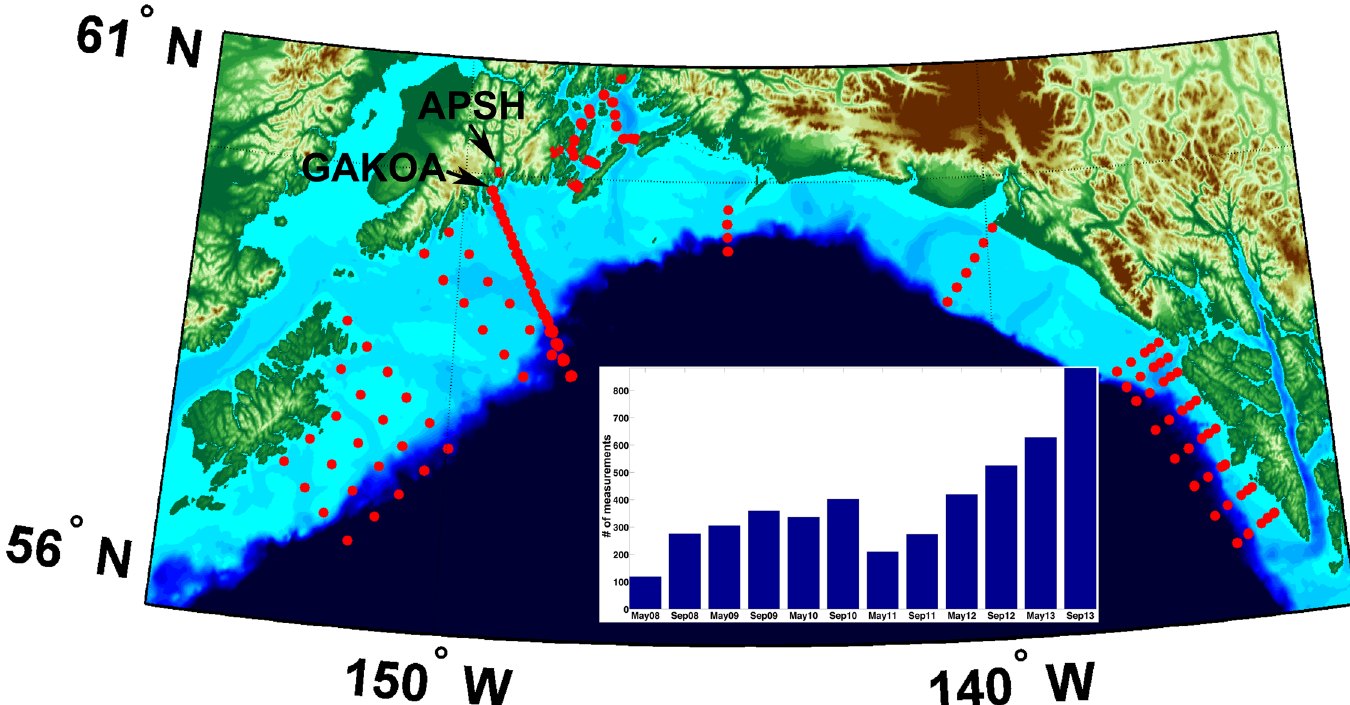
Fig 1. Map showing the location of Alutiiq Pride Shellfish Hatchery (APSH) in Resurrection Bay, the position of the Gulf of Alaska OA (GAKOA) mooring at the mouth of Resurrection Bay. Red dots are locations of discrete total alkalinity (TA) and salinity measurements, with the number of measurements made during cruises in May and September from 2008 through 2013 shown in the